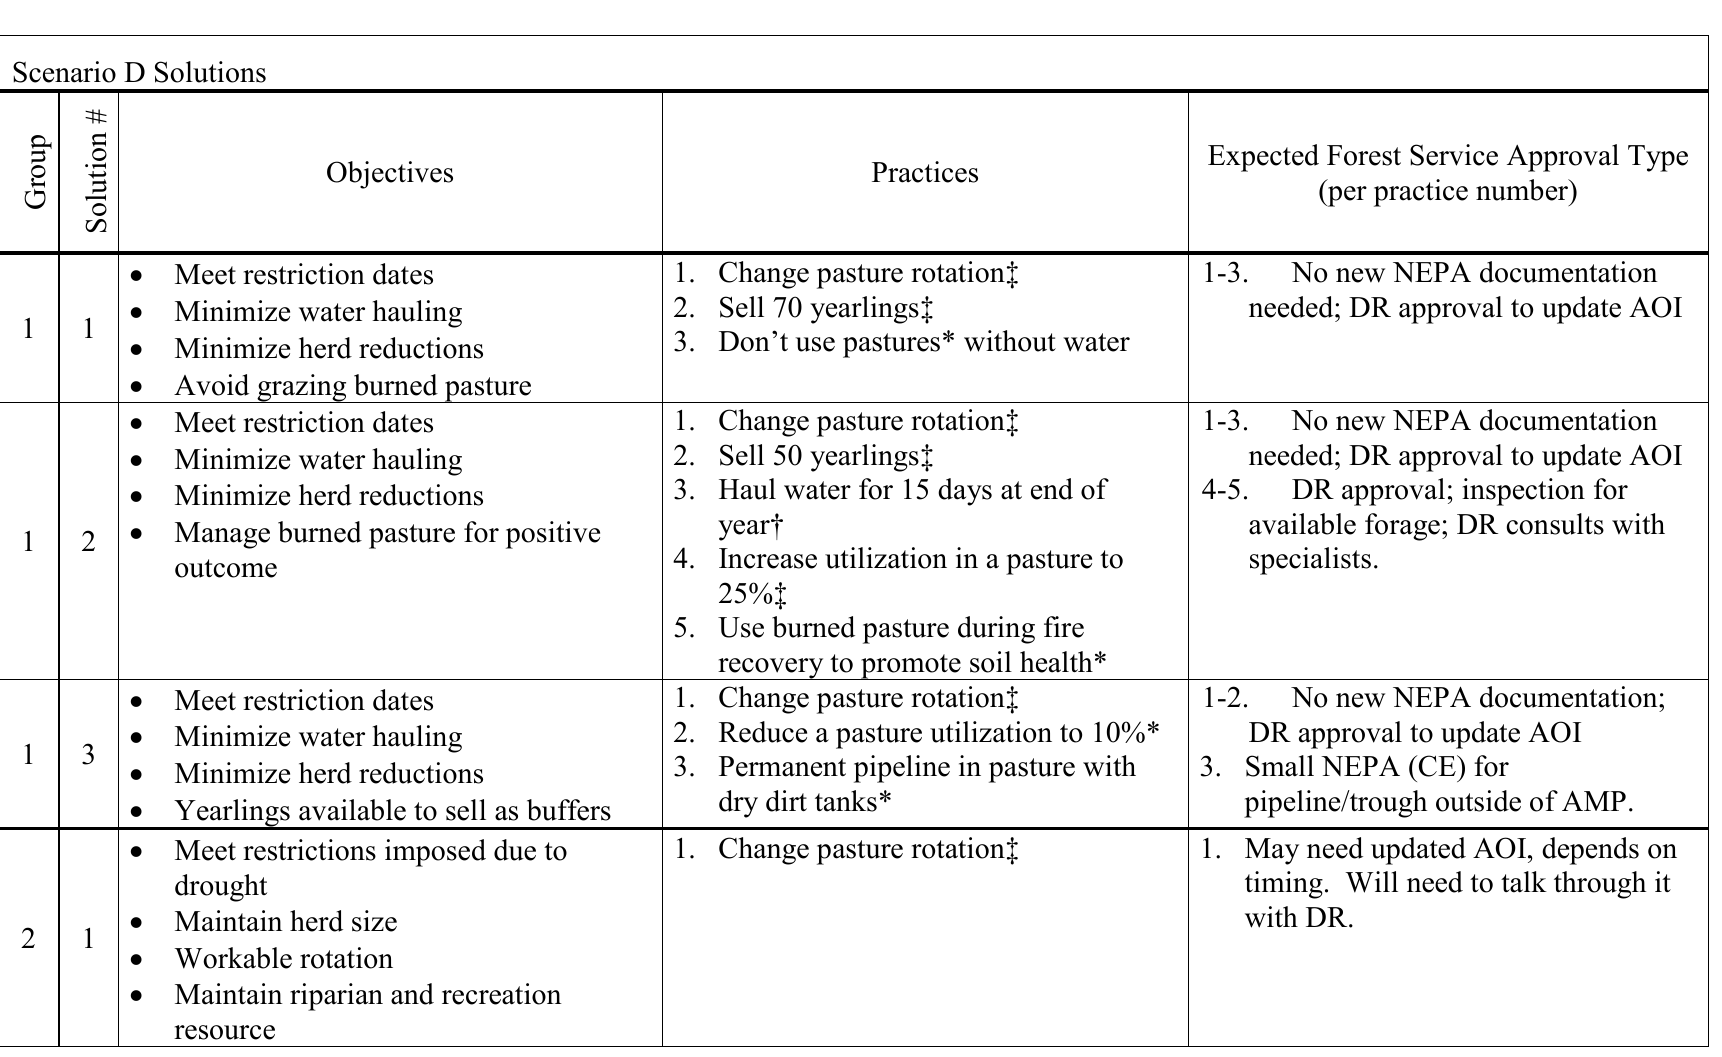
Table A1.2: Solutions from Group Scenario-Planning Exercise